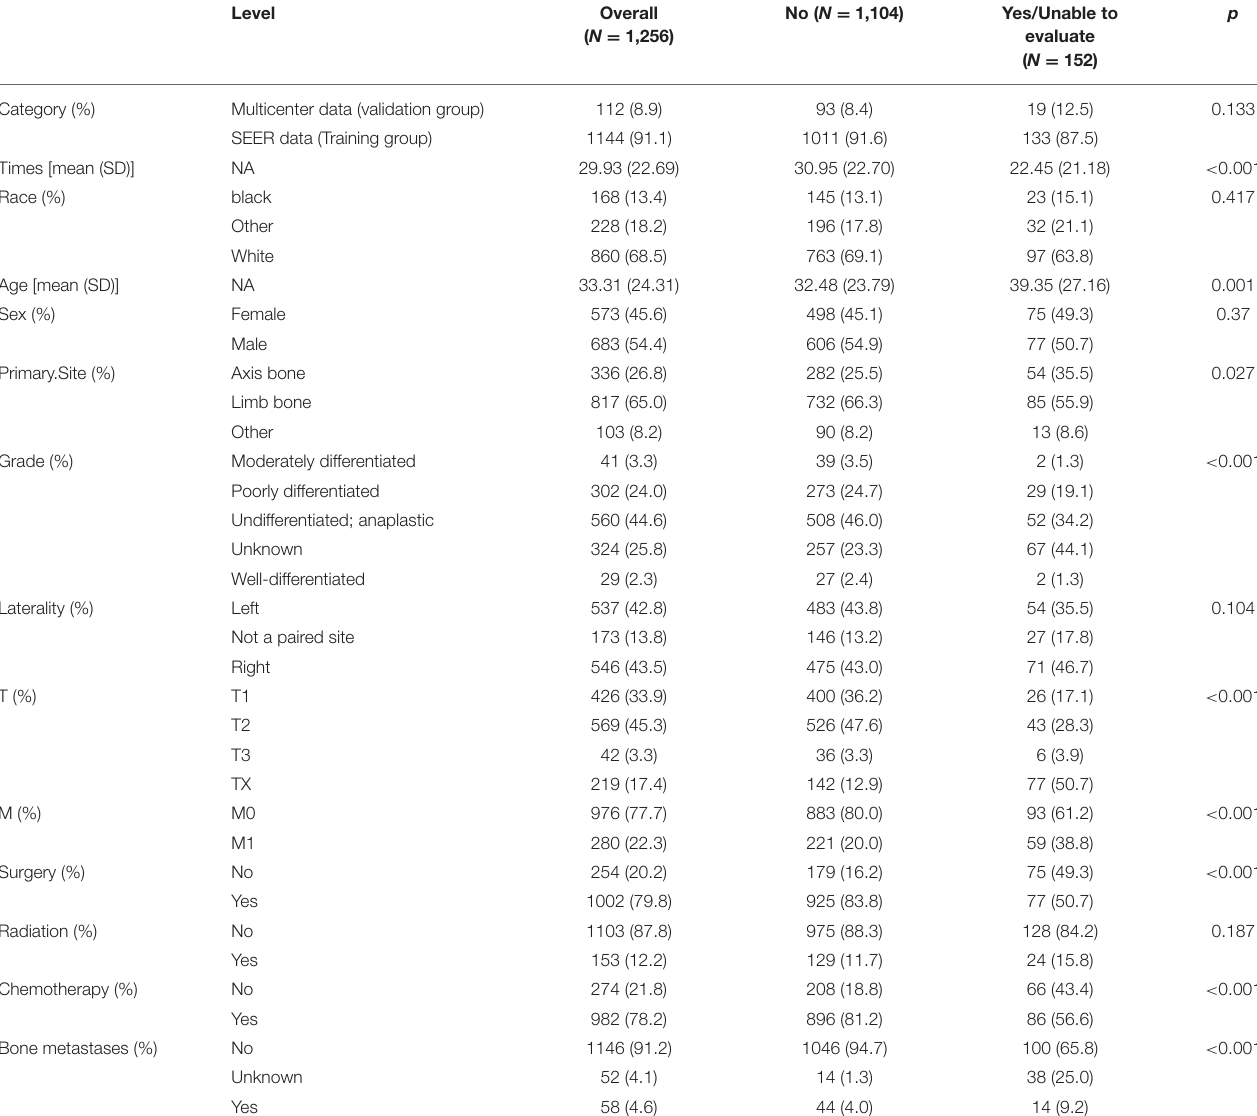
TABLE 2 | Patient baseline table of lymphatic